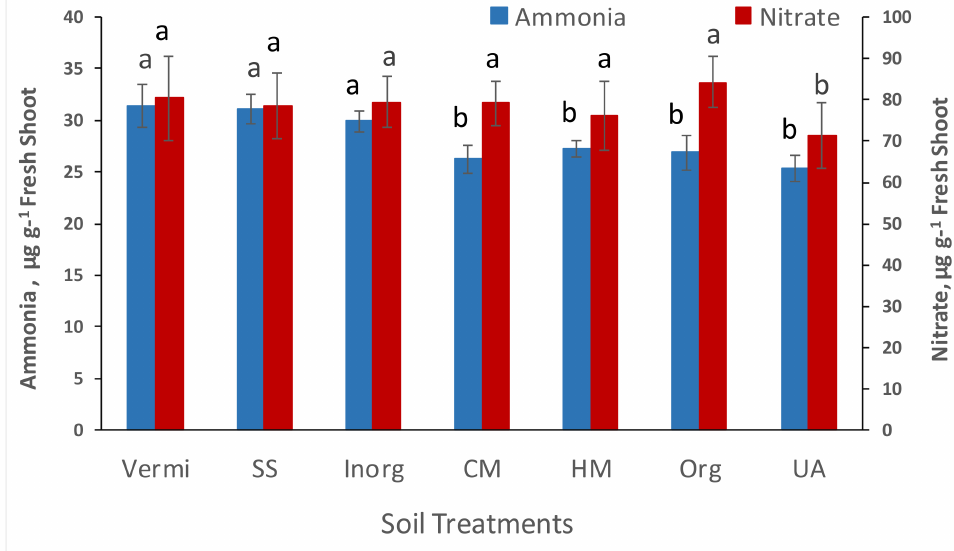
Figure 4. Concentrations of ammonia and nitrates ± std. error in turnips shoot of plants grown under seven soil treatments, regardless of turnips variety. Vermi vermicompost, SS sewage sludge, Inorg inorganic fertilizer, CM chicken manure, HM horse manure, Org elemental organic fertilizer, and unamended (UA) native soil. Statistical analysis was carried_out using analysis of variance (ANOVA). Standard errors having different letter indicate significant differences ( p ≤ 0.05) using Duncan’s multiple range test for means